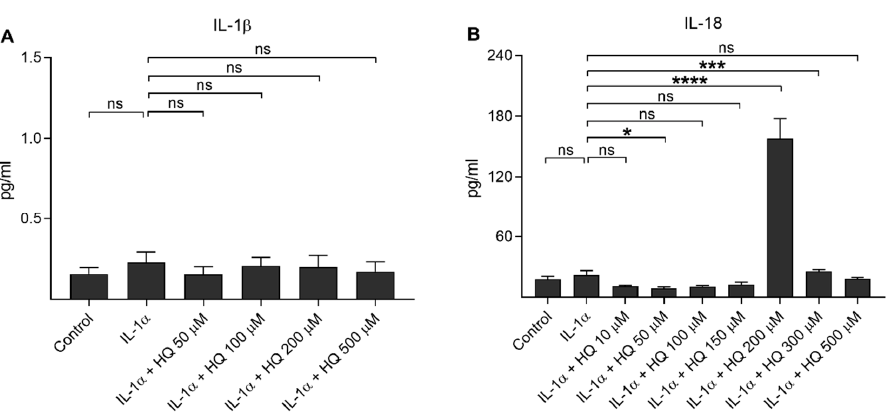
Figure 2. The effect of hydroquinone (HQ 10–500 µ M; 18 h) on the release of IL-1 β ( A ) and IL-18 ( B ) from IL-1 α -primed ARPE-19 cells. Data were combined from three independent experiments